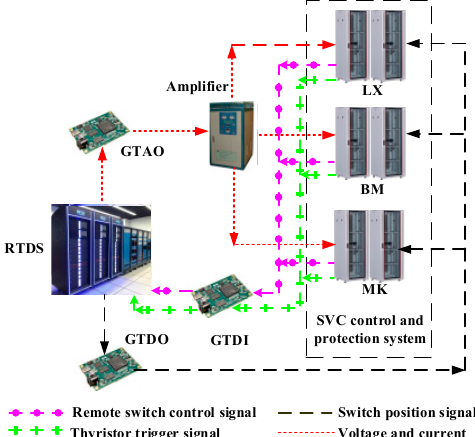
Figure 15. RTDS hardware-in-the-loop platform for verifying the proposed strategy.